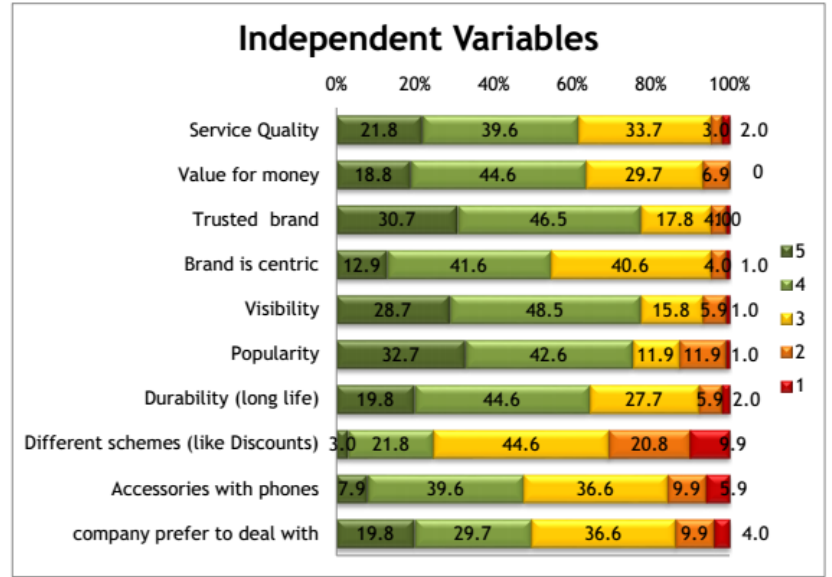
Fig.1. Descriptive information of exogenous